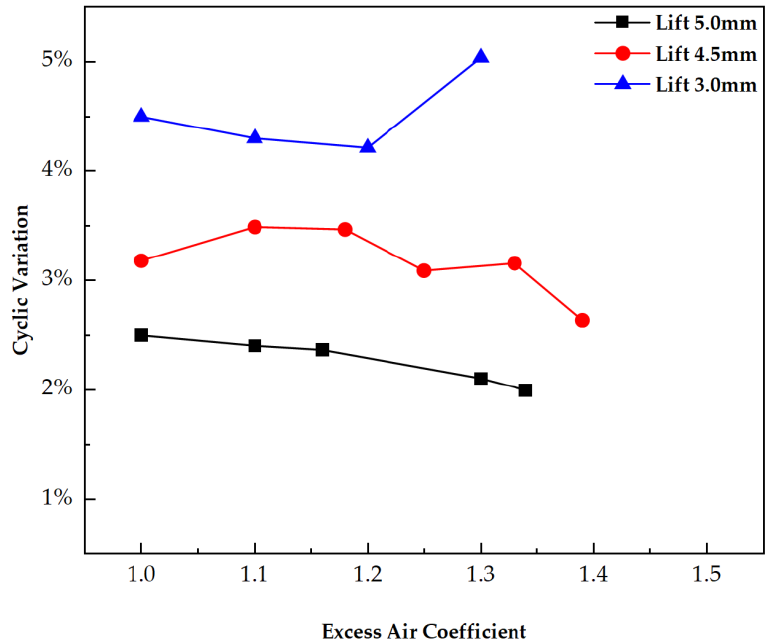
Figure 9. The cyclic variation of HCCI combustion under different exhaust valve lifts at 1400 rpm.